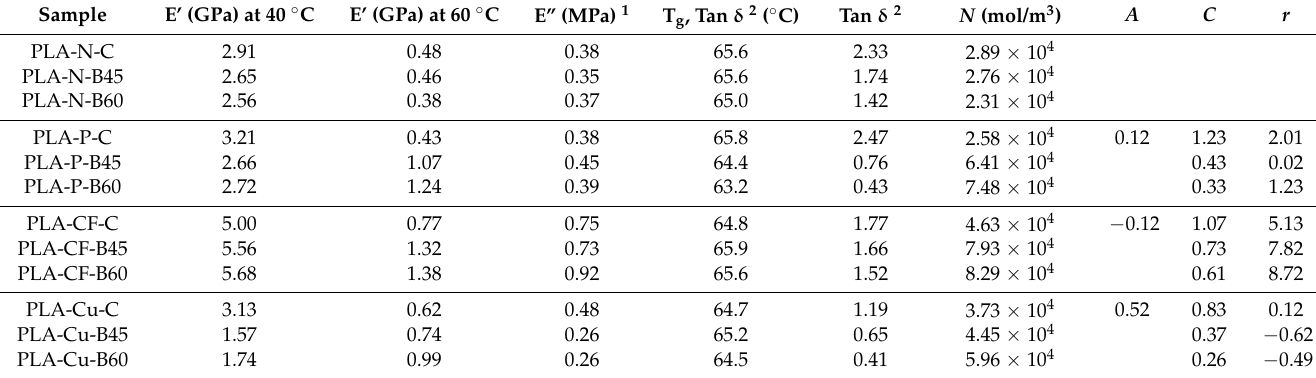
Table 5. Dynamic mechanical properties of compression molded sheets and 3D printed